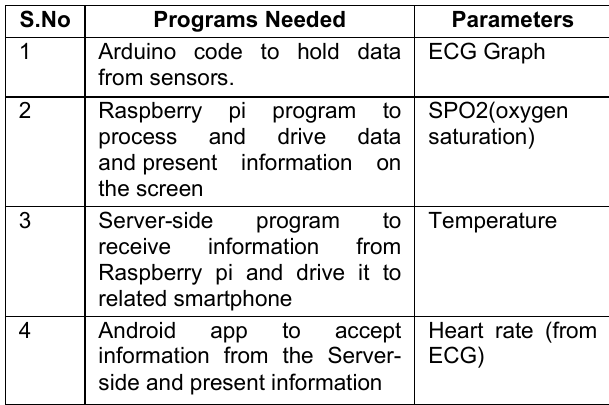
Table 1. Healthcare Programs and